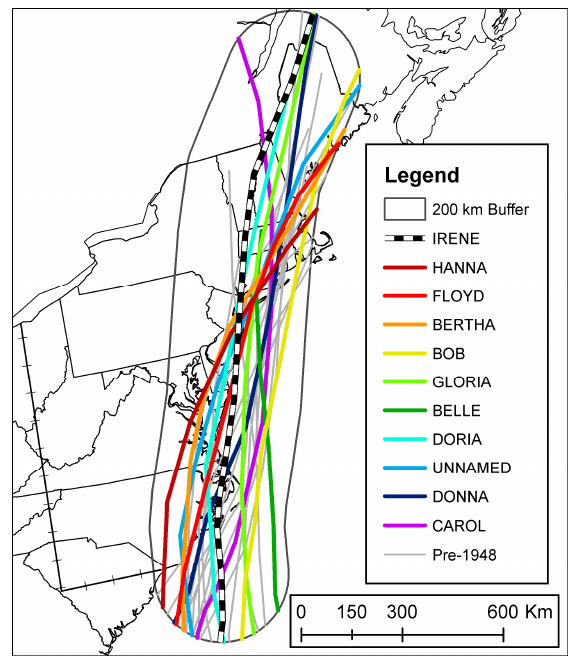
Figure 1. Tracks of tropical cyclones included in the study with 200 km buffer for the track of Irene. The western and southern extent of the rainfall study region is denoted with a hatched line. Years associated with each name are included in Table 1.